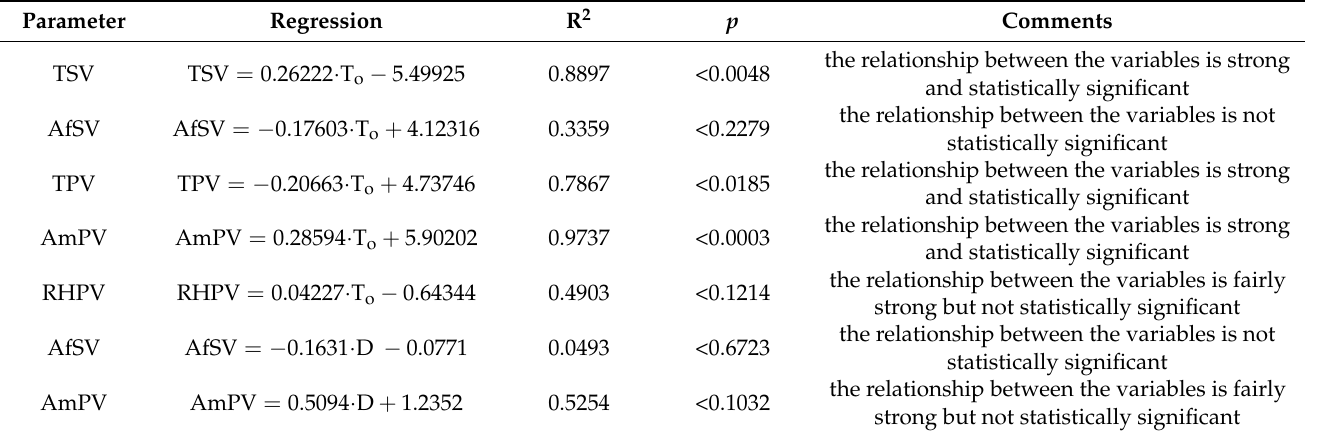
Table 8. The outcomes of the regression analysis for indices of sensations and preferences. Parameter Regression R 2 p